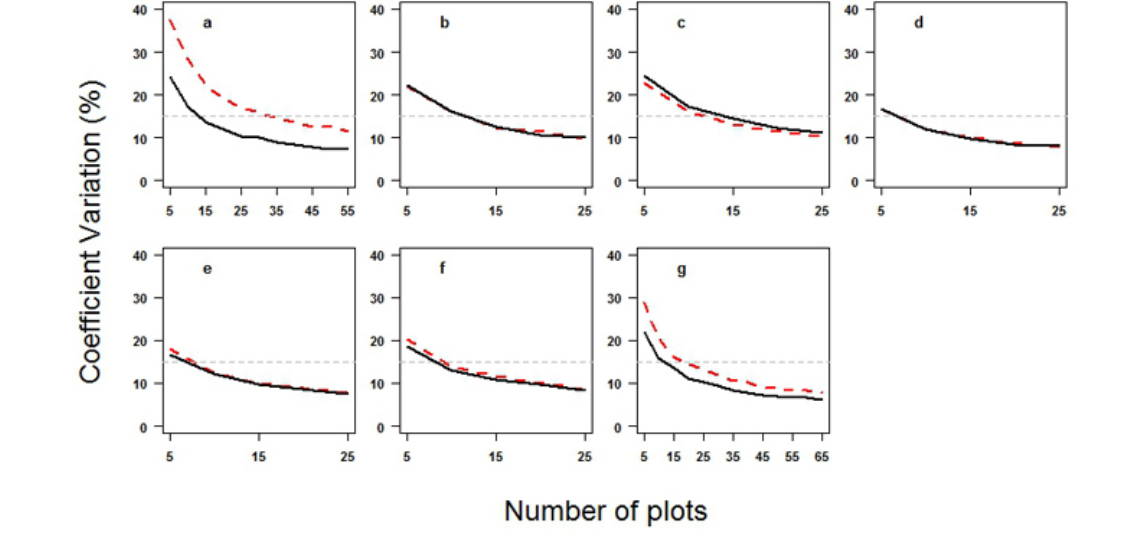
Fig. 3 . Relationship between the number of plots and the coefficient of variation for forest biomass measurements by community members (stippled red line) and professional foresters (black line) in lowland dipterocarp forest in Batu Majang, Indonesia (a), mountain rain forest in Manlin, China (b– c), evergreen monsoon forest in Sakok, Laos (d–e), and Diem (f) and Moi (g), Vietnam (with coefficient of variation = 15% dashed line; n = 289 permanent plots). Data from the three sites in Moi were lumped together for the purpose of preparing this